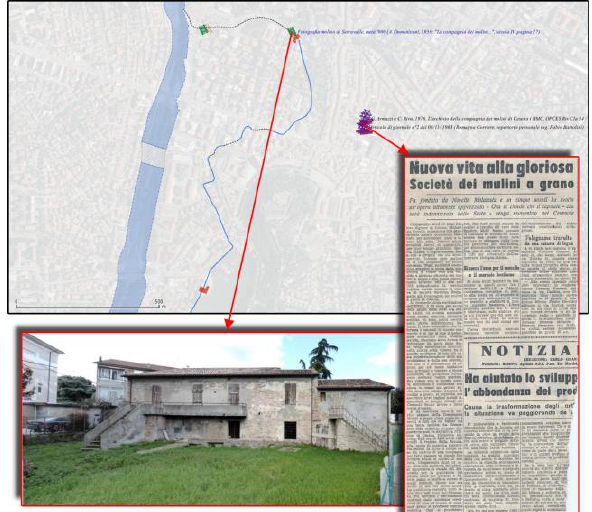
Figure 12. Two documents linked to the vector layer of 1953: